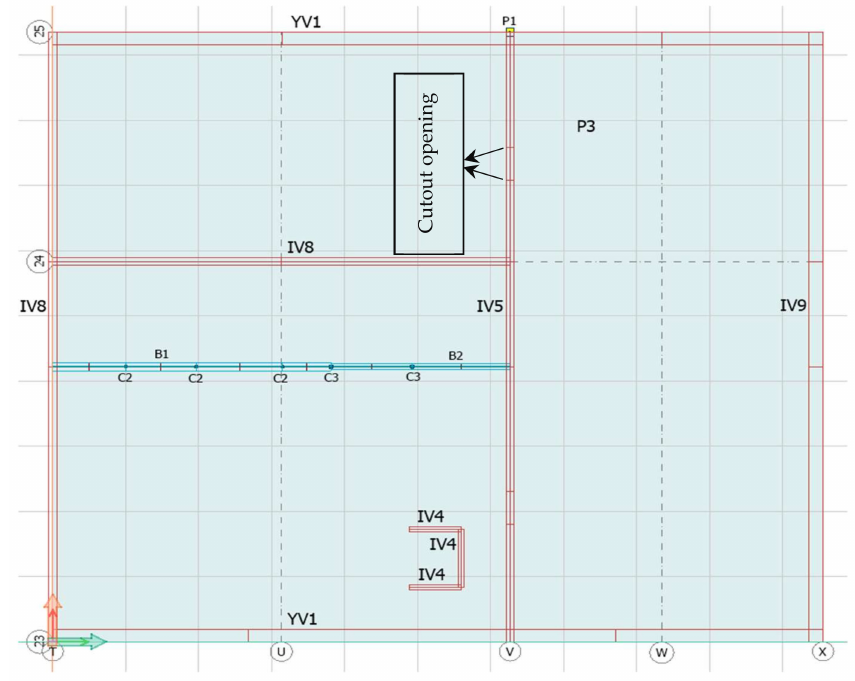
Figure 8. Floor plan of story 2 with named load-bearing elements.